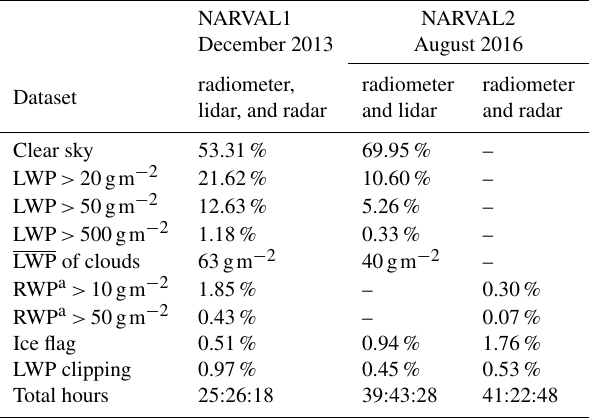
Table 3. Comparing NARVAL1 and NARVAL2 cloud properties observed south of 20 ◦ N and with HALO altitude above 6km. Per- centages of flight time with available corresponding datasets during each